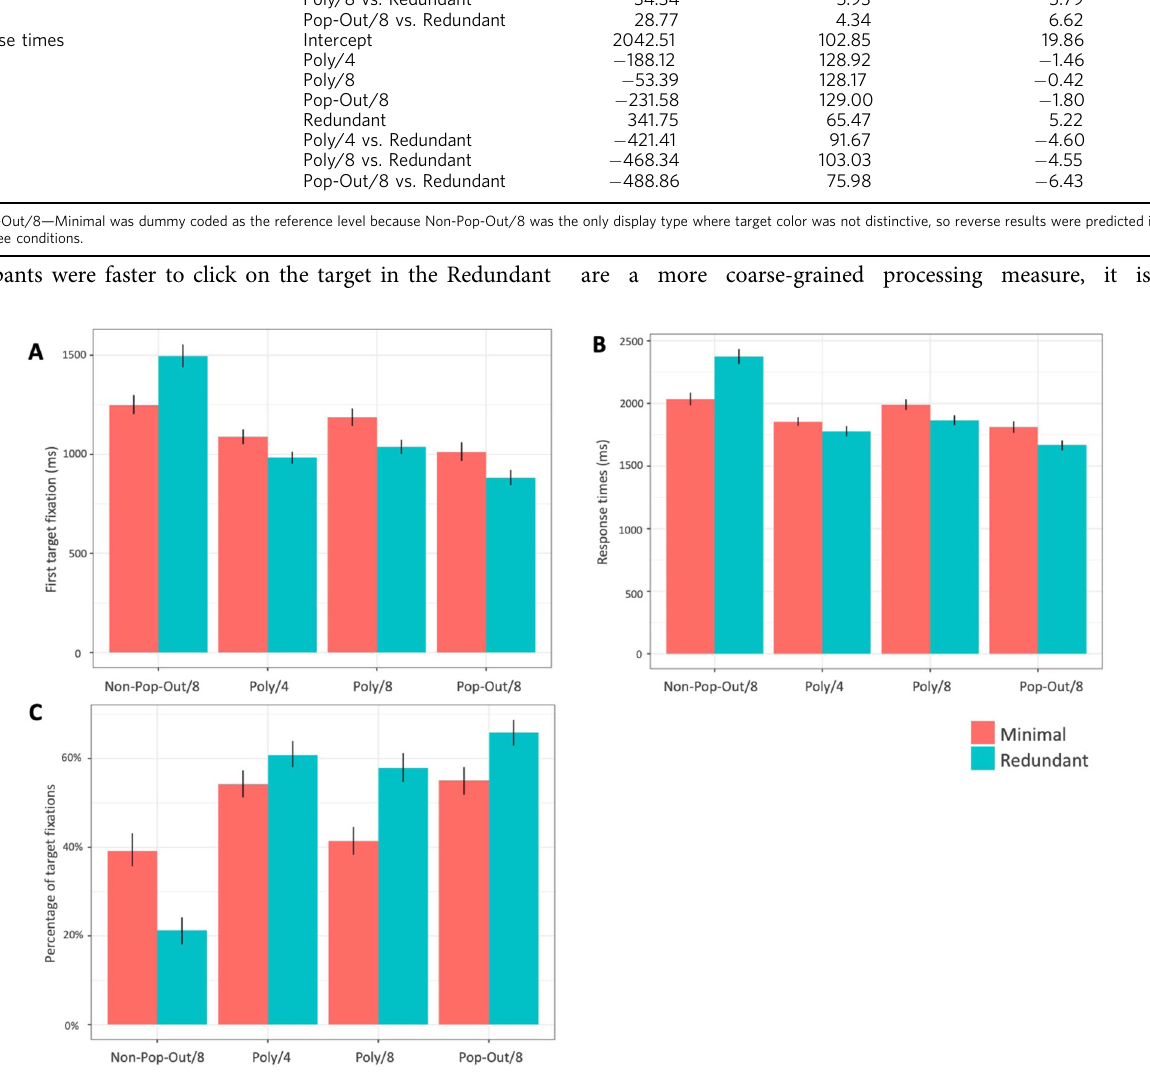
Fig. 6 Descriptive statistics from Experiment 1. A Mean delay of fi rst target fi xation and B mean RTs by Display and Instruction type. C Mean percentages of target fi xation during the critical time window. Non-Pop-Out/8 was the only condition where color did not discriminate the target. Error bars indicate 95% boostrapped con fi dence intervals.